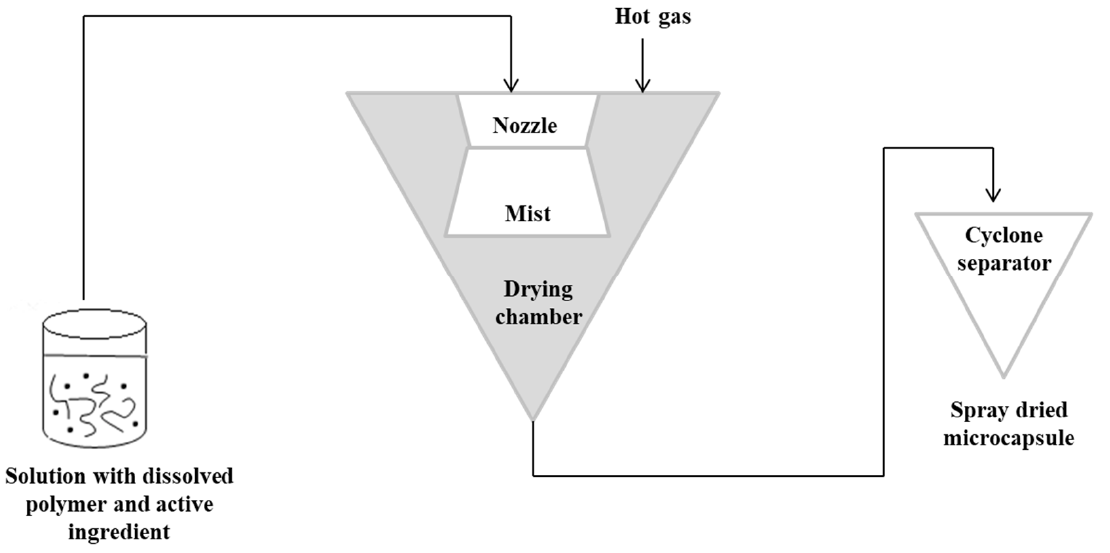
Figure 3. Scheme of the spray-drying encapsulation technique.